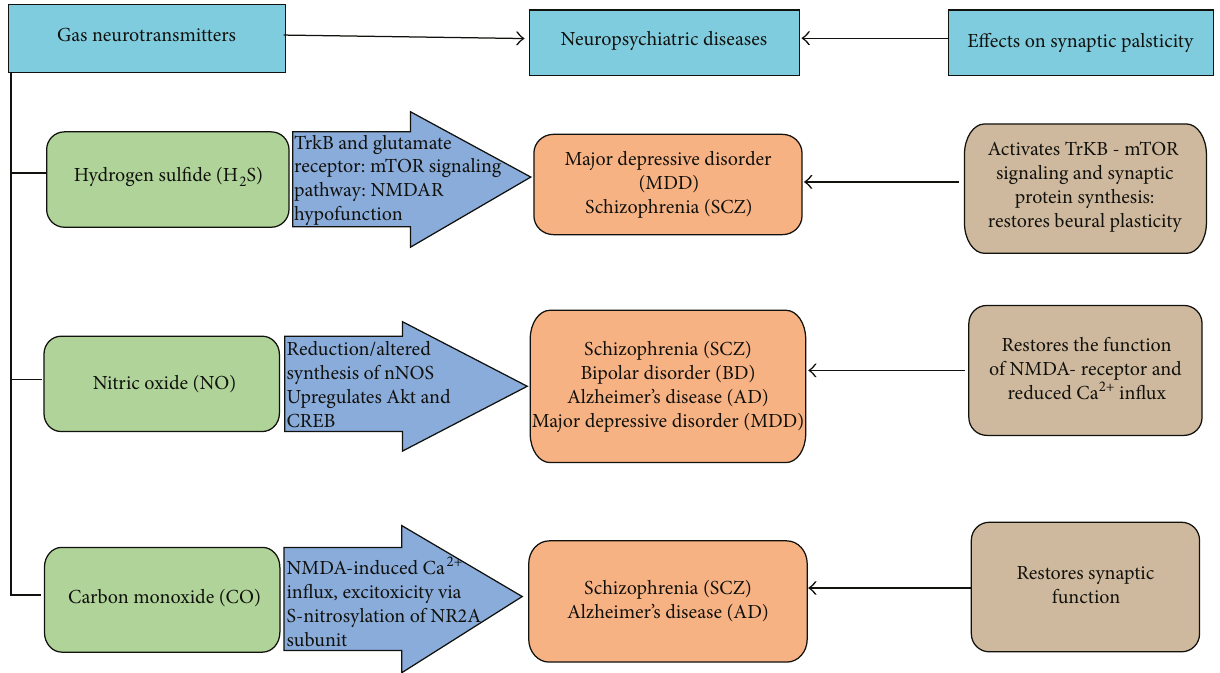
Figure 2: Role of gas neurotransmitters in neuropsychiatric diseases. The three gas neurotransmitters such as hydrogen sul fi de (H oxide (NO), and carbon dioxide (CO) have a role in neuropsychiatric conditions such as major depressive disorder (MDD), schizophrenia (SCZ), bipolar disorder (BD), and Alzheimer ’ s disease (AD) to maintain proper synaptic plasticity as well as neural homeostasis. H a role in tropomyosin receptor kinase B (TrKB) and glutamate as well as mechanistic targets of rapamycin (mTOR) signaling pathways, and it activates the TrKB-mTOR signaling pathway as well as synaptic protein in MDD. NO has a role in the regulation of altered synthesis of nNOS as well as upregulates Akt and cyclic AMP (cAMP) response element binding (CREB) protein which restores function in N -methyl-D aspartate (NMDA) receptor and reduces Ca 2+ in fl ux in schizophrenia, MDD, and AD. CO has a role in NMDA- induced calcium ion (Ca 2+ ) in fl ux or excitotoxicity via S-nitrosylation of antiglutamate receptor NMDAR2A (NR2A) subunit and restores synaptic function in AD and SCZ. However, these gas neurotransmitters work on various ways to maintain or restore synaptic plasticity in these neuropsychiatric